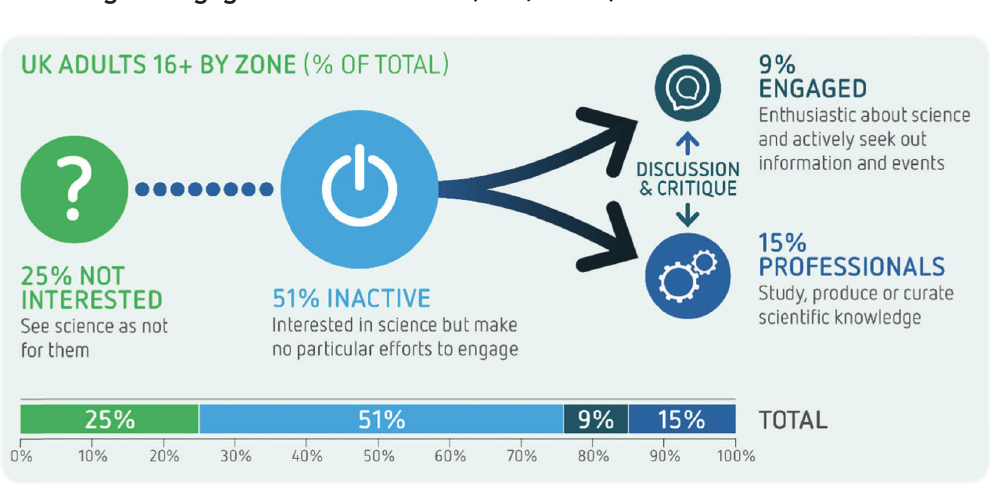
Figure 1: The BSA’s audience model is used to determine an event participant’s engagement with science – audiences classed as ‘not interested’ or ‘inactive’ have a lower engagement with science, whereas ‘engaged’ and ‘professionals’ audiences have a higher engagement with science (BSA, n.d.